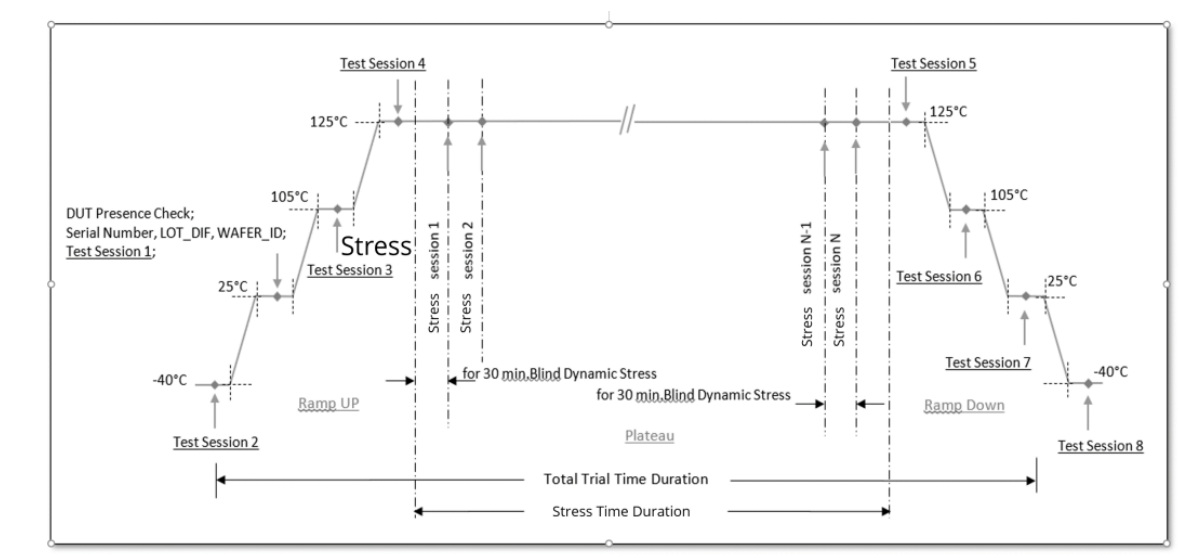
Figure 6. Test for Reliability Flow.